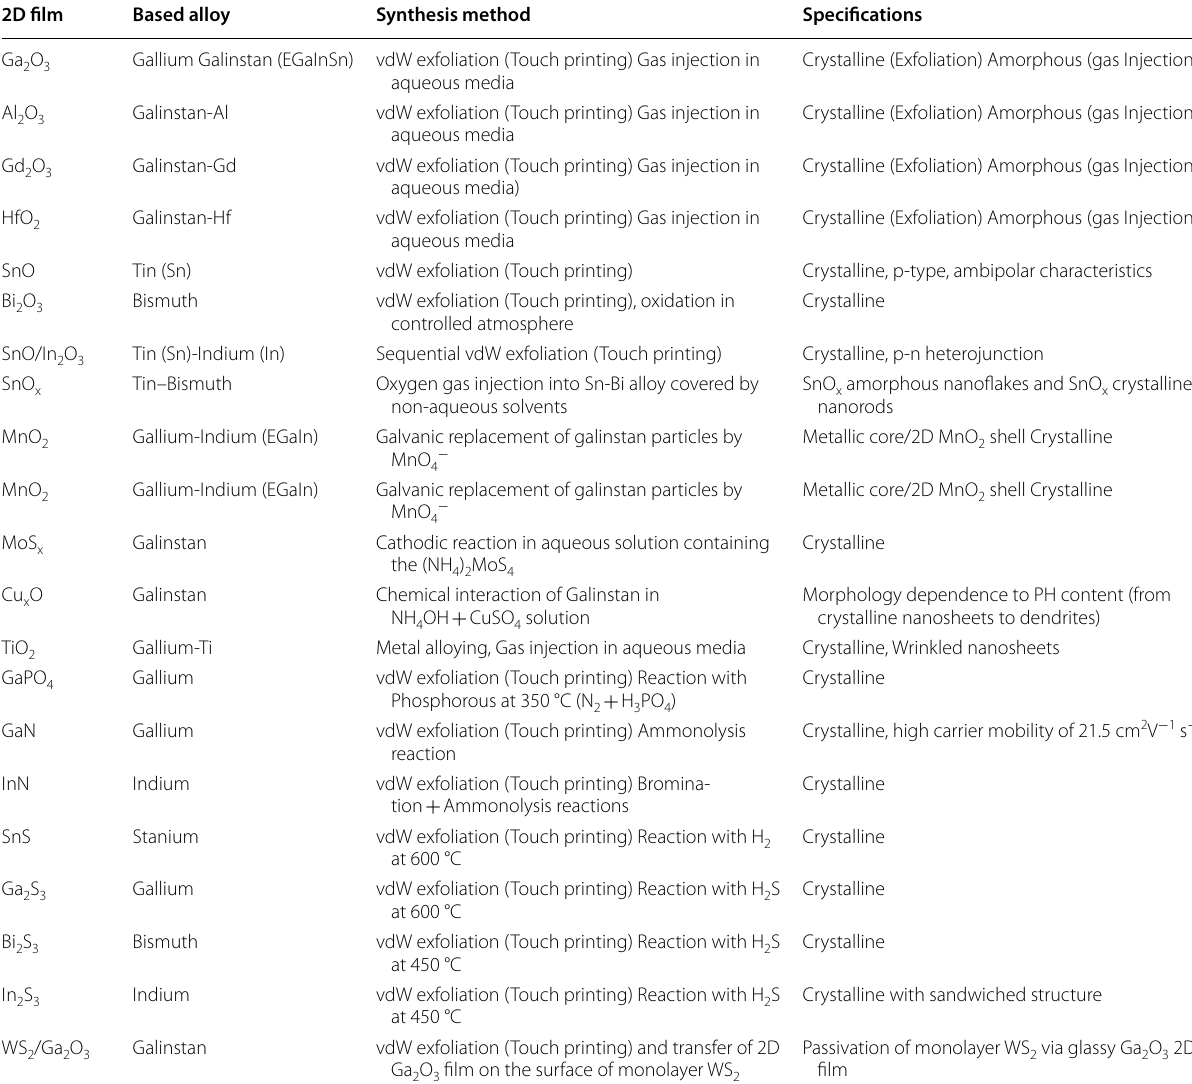
Table 4 Summary of properties of 2D surface films of liquid metals. Reprinted with permission from [168] 2D